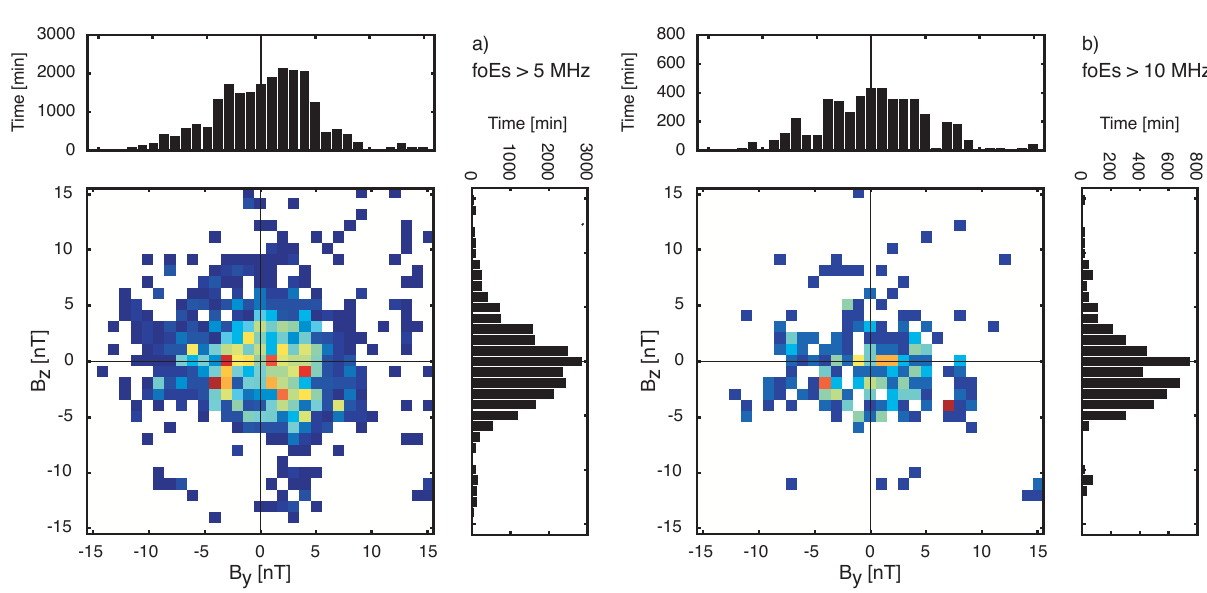
Fig. 2. Bivariate and marginal distributions of sporadic-E occurrence with B y and B z at Longyearbyen in 1999–2000. Distributions (a) and (b) refer to layers with peak plasma densities higher than 5MHz and 10MHz, respectively. The pixel size in the B y B z plane is 1nT × 1nT. In the colour scale, white indicates zero value, and the colours from blue via yellow and green to red cover the range from small nonzero values to